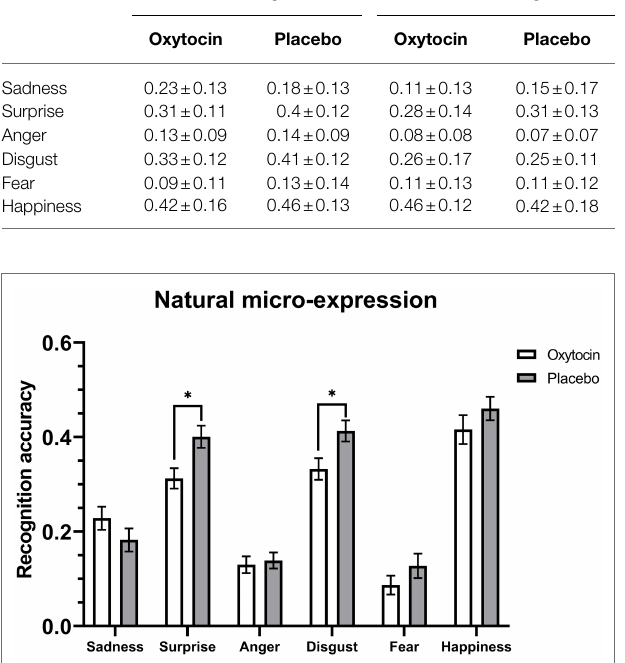
FIGURE 3 | Mean recognition accuracies of natural micro-expressions under the training condition. Error bars represent standard errors. The symbol * indicates that the differences were significant.